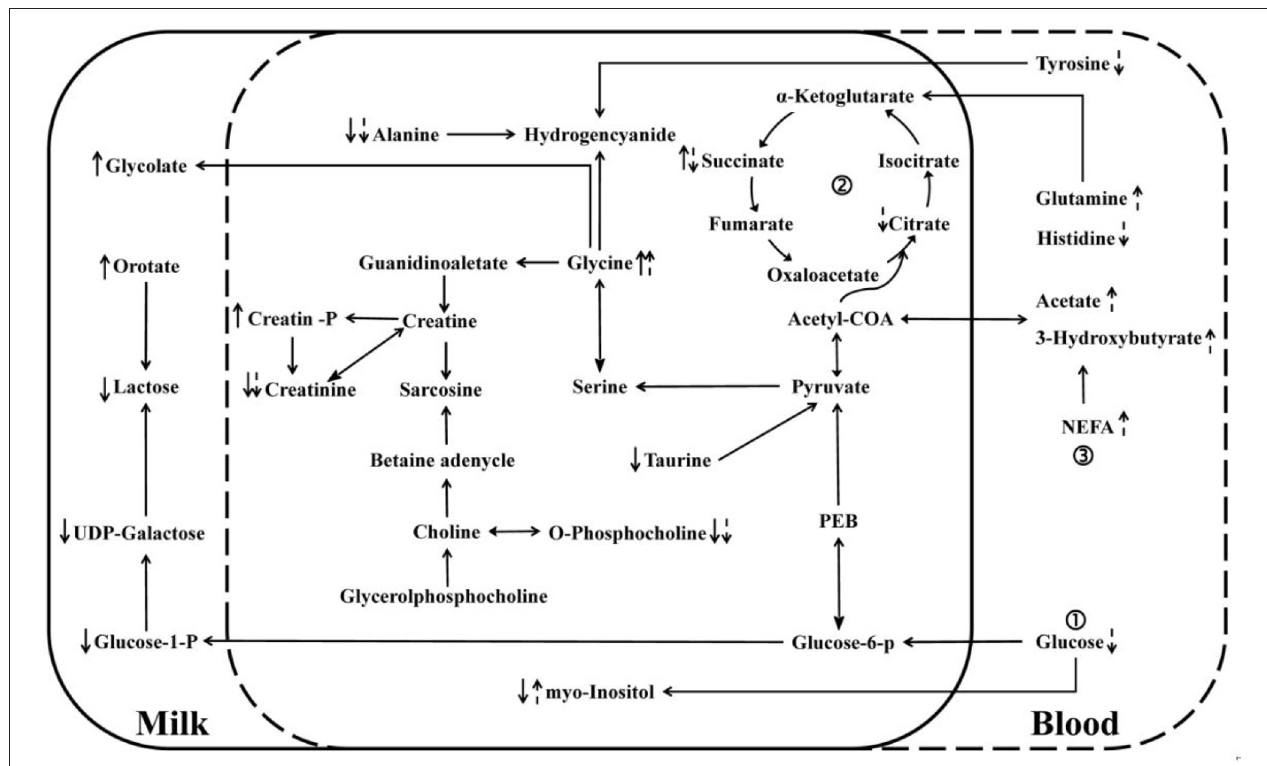
FIGURE 5 | Network interaction diagram of differential metabolites in whey and serum. “ ↑ ” and “ ↓ ” denote an increase and decrease, respectively. Solid arrows indicate changes in milk whey, and dashed arrows indicate changes in serum glucose metabolism, trichloroacetic acid (TCA) cycle, and lipid